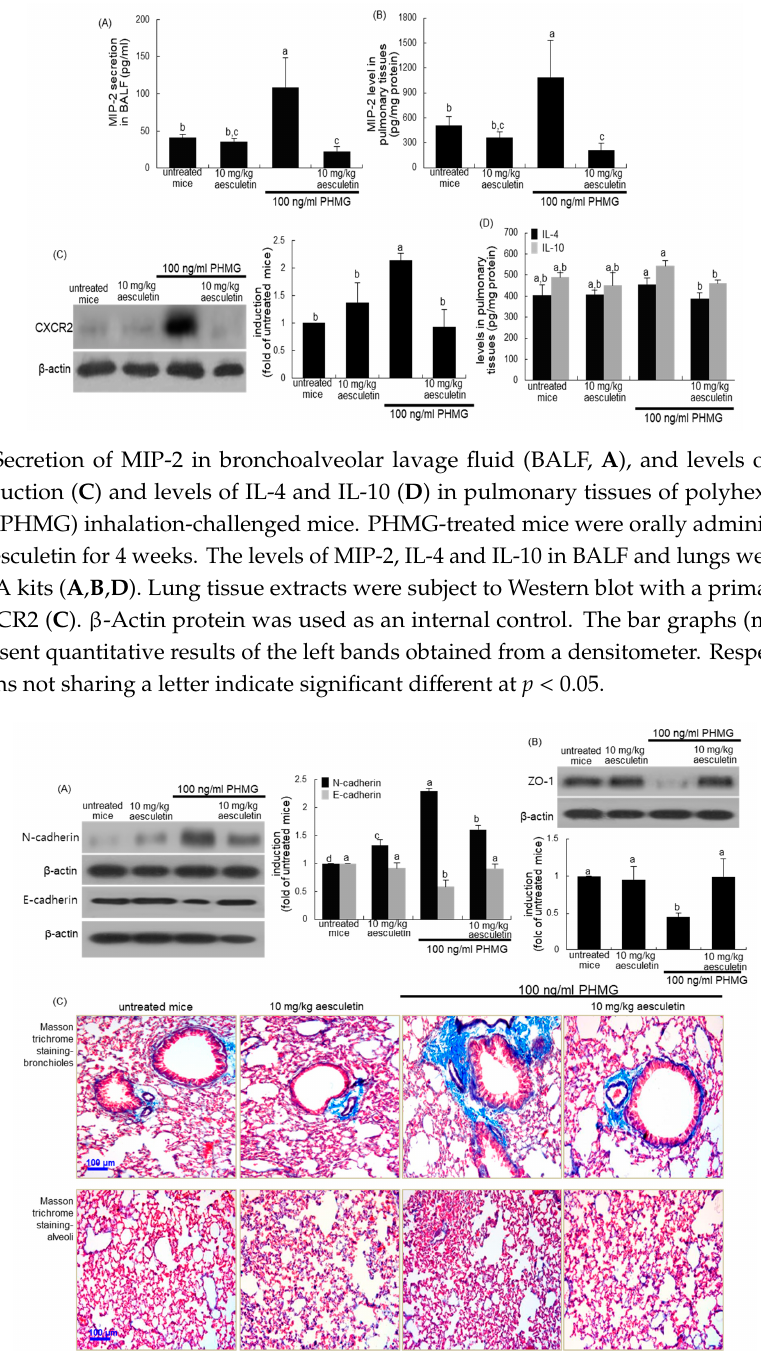
Figure 8. Inhibitory effects of aesculetin on markers of EMT ( A , C ) and tight junction ( B ) of polyhexamethylene guanidine (PHMG)-challenged mouse small airways and alveoli. Mice were orally administrated with 10 mg/kg aesculetin and exposed to 100 ng/mL PHMG for 4 weeks. Lung tissue extracts were subject to Western blot analysis with a primary antibody against N-cadherin, E-cadherin and ZO-1 ( A , B ). The bar graphs (mean ± SEM, n = 3) represent quantitative results of the left or upper bands obtained from a densitometer. Respective values in bar graphs not sharing a letter indicate significant different at p < 0.05. Masson trichrome staining was done in small airways and alveoli of PHMG-challenged mice ( C ). Each photograph is representative of four mice. Airway tissue sections were stained by using H&E reagent ( A ). Each photograph is representative of four mice. Scale bars = 100 μ m.